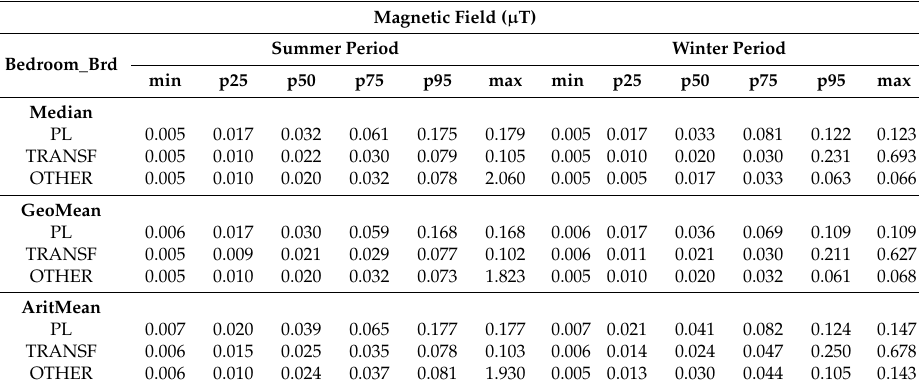
Table A2. Distribution values of the median, geometric mean (geomean) and arithmetic mean (aritmean) of magnetic field ( µ T) in the broadband (Brd) frequency range (40–800 Hz) for bedroom measurements for each group (PL, TRANSF, OTHER) in both summer and winter periods.